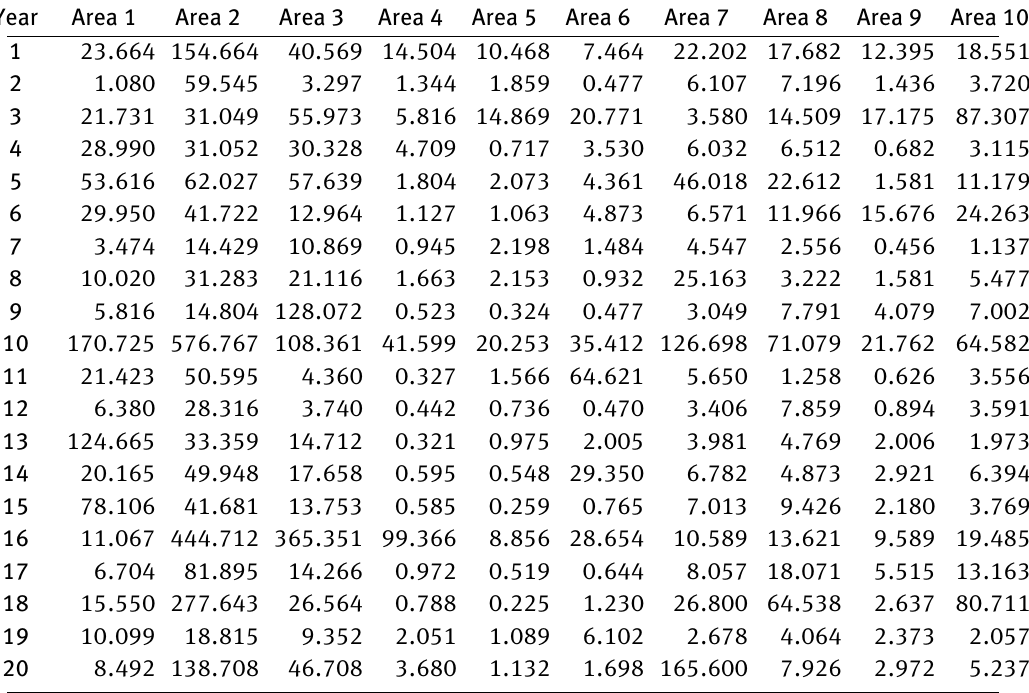
Table 2: Loss data, part